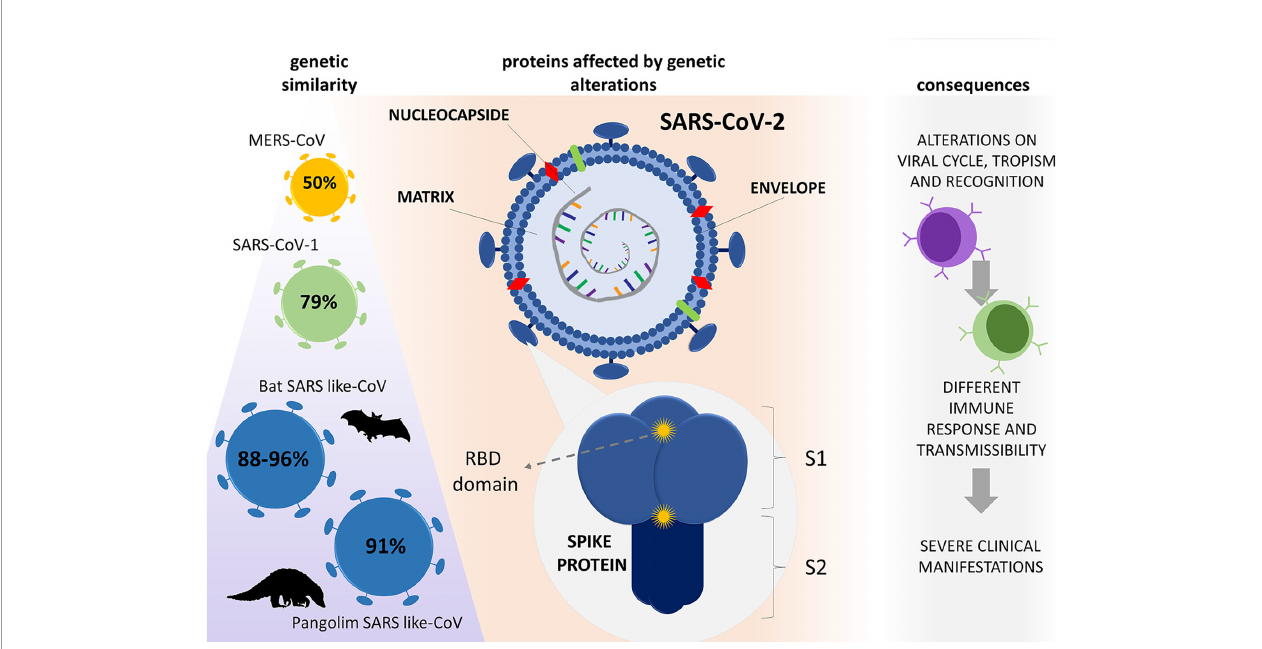
FIGURE 1 | Genetic evolution of SARS-CoV-2 and its consequences. Compared with other b -CoVs, SARS-CoV-2 has similarities of 50, 79, and 88 - 96% to MERS-CoV, SARS-CoV-1, and bat SARS-like-CoV genome, respectively, with 91% similarity with SARS-like CoV found in pangolins. The virus resulted from mutations that caused changes in important proteins for its virulence; notably, the spike, matrix, envelope, and nucleocapsid proteins caused alterations in host cell interactions, which culminated in a new aggressive disease (COVID-19). RBD (receptor binding domain), S1 (subunit 1) S2 (subunit